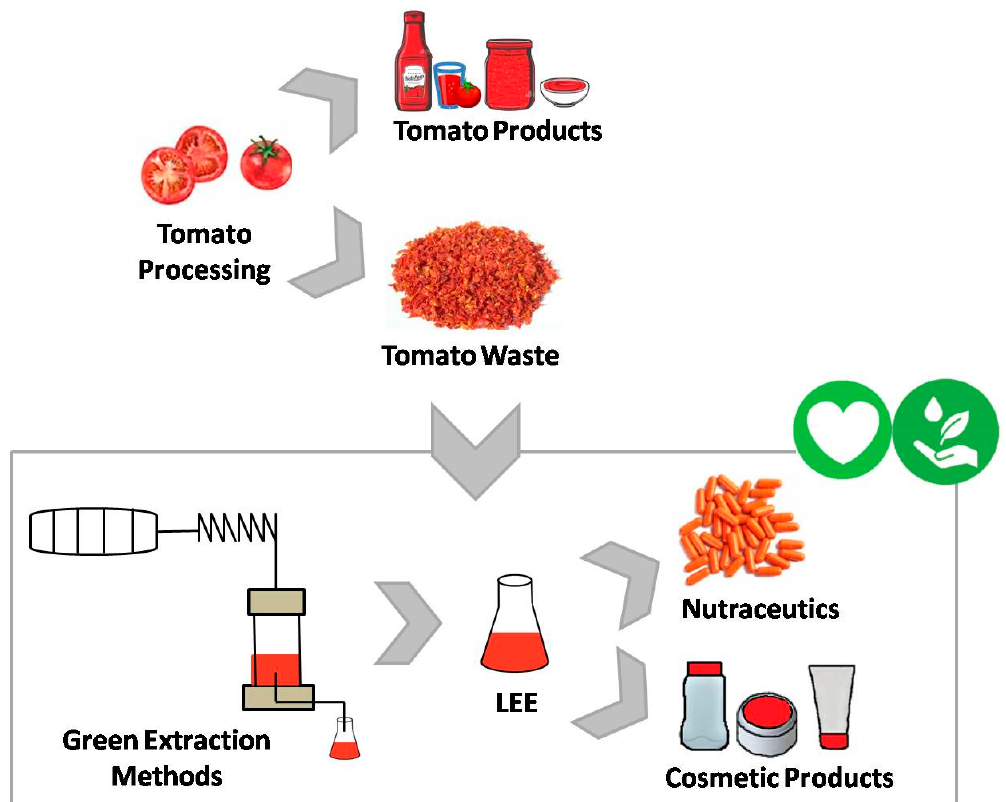
Figure 1. Schematic representation of lycopene extraction from tomato processing waste and its application on new products. LEE: Lycopene-enriched extracts.